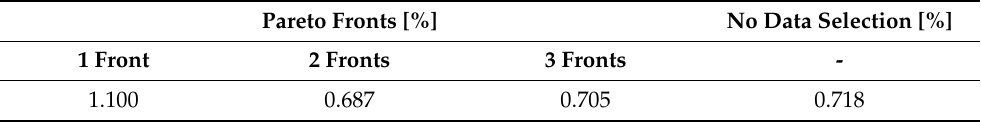
Table 4. MAPE values for Pareto fronts and ‘no data selection’ models for the second verification case.